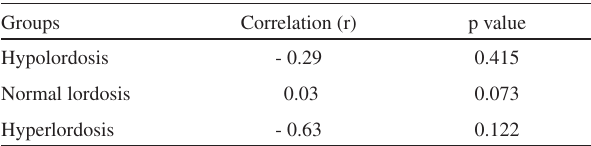
Table 5 - Spearman’s correlation (r) and p value for the mode of the degree of cellulite and the lumbar lordosis angle in groups showing hypolordosis, normal lordosis,